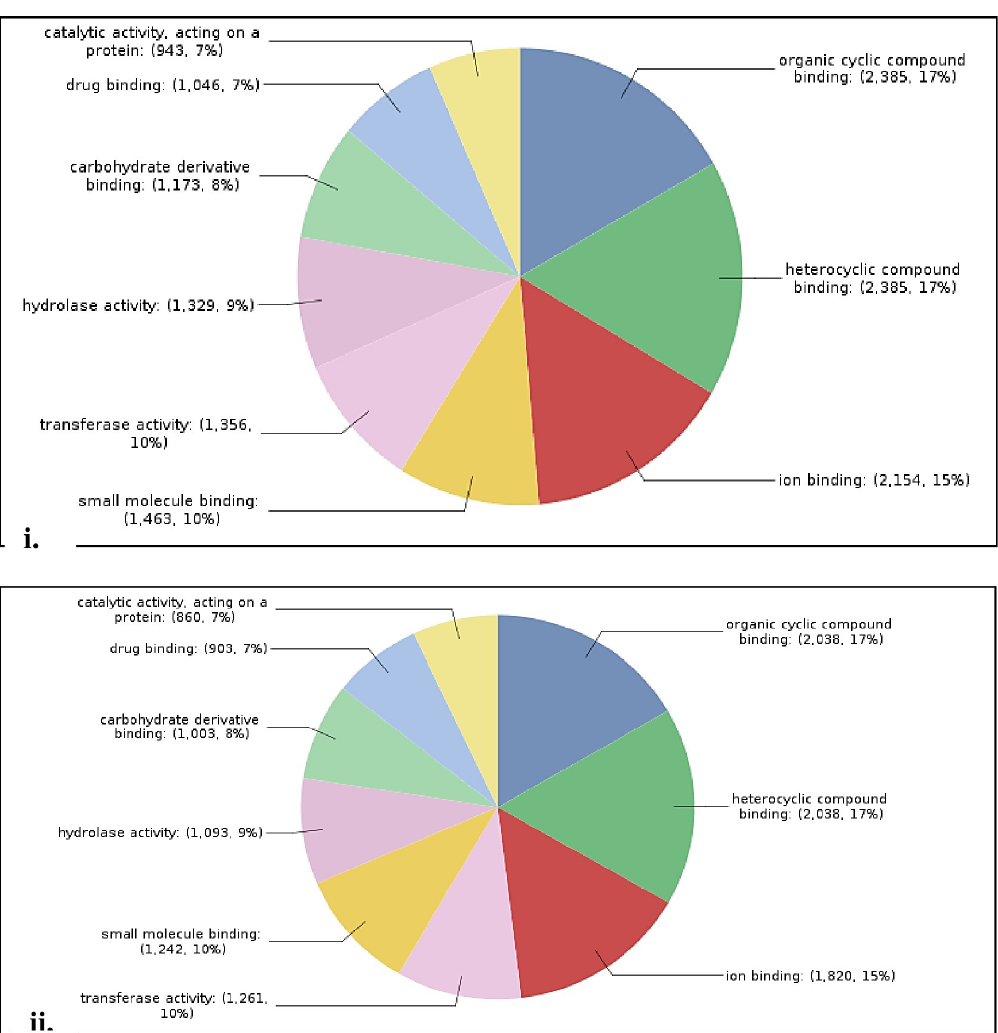
Fig 4. Visualization of differentially expressed gene transcription by (A) Scatter plot of differentially expressed genes between Sa SHc and Sa SLc (significant at P value < 0.05); green dots represent the downregulated (significant) and red dot represents the upregulated (significant) genes for DGE combination (B) Volcano plot of differentially expressed genes; green dots represent the downregulated (significant) and red dot represents the upregulated (significant)genes for DGE combination (significant at P value < 0.05).